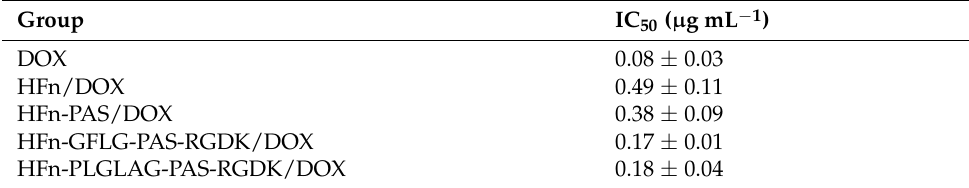
Figure 4. Proliferation inhibition on 4T1 cells. Data were mean ± standard deviation ( n = 4). Table 2. IC 50 values of all